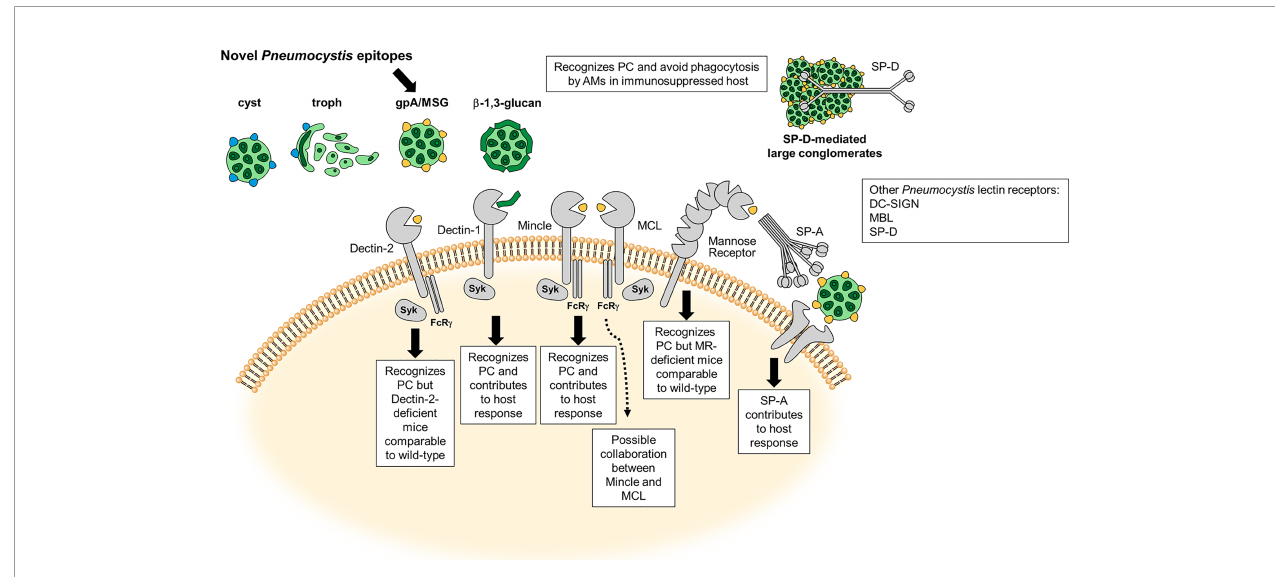
FIGURE 1 | Carbohydrate Recognition and C-type Lectin (CLR) Receptors in Pneumocystis (PC). Schematic illustration adapted from Hoving (10) of the most characterized carbohydrate recognition receptors for the fungal organism and brief description of the host response. Major surface glycoprotein (Msg) is a novel ligand on the Pneumocystis cell surface. The dotted line represents a possible connection with MCL and Mincle on in fl ammatory signaling in the presence of Pneumocystis Msg (11).